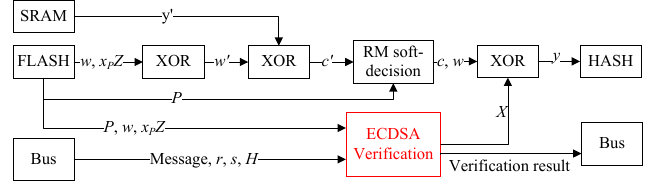
Figure 16. Fast ECDSA-PUF and custom ECDSA data flow.